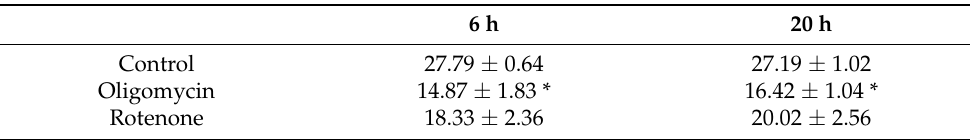
Table 1. Quantitative image analyses of the effects of oligomycin and rotenone on mitochondrial membrane potential.